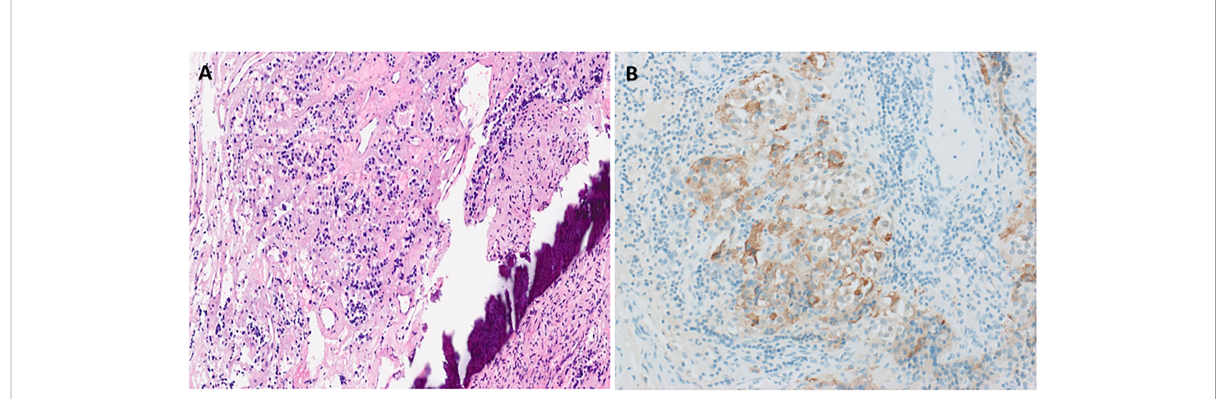
FIGURE 2 Histopathological con fi rmation of ectopic TSHoma. Histopathology (obtained from tumor resection) with hematoxylin and eosin staining (A) showing small irregularly shaped islands of cells separated by fi brovascular stroma beside the bone (dark purple streak). Cells have small amounts of lightly eosinophilic, granular cytoplasm and small – intermediate-sized round nuclei with no mitoses identi fi ed. Strong diffuse positive tumor cell staining on immunohistochemistry for TSH is also seen (B)